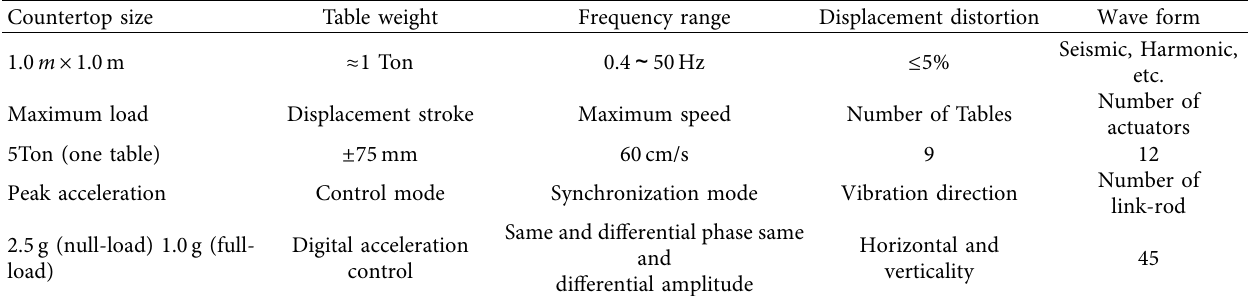
Figure 2: The shaking table array system: (a) detail of the shaking table; (b) layout plan. Table 1: Design parameters of the shaking table